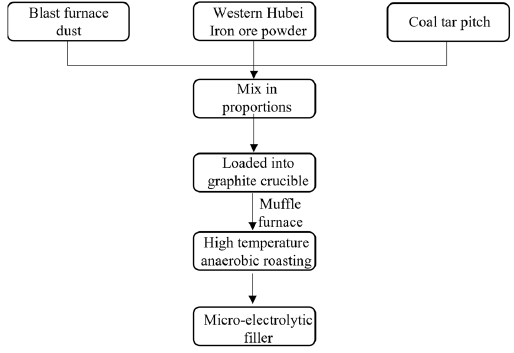
Figure 2. Flow chart of the preparation of micro-electrolytic fillers.